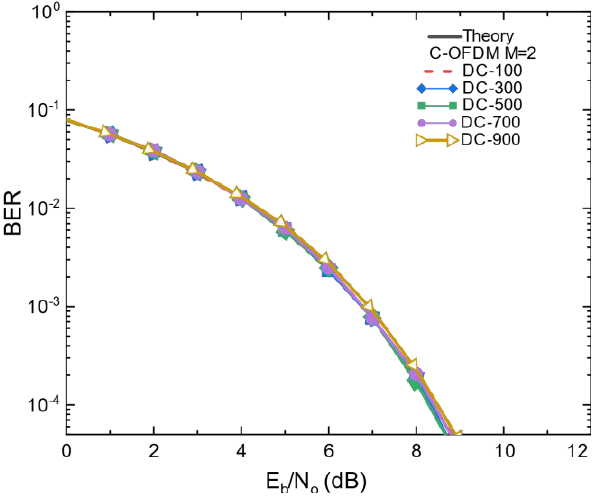
Figure 6. BER performance as a function of E b /N o for F-OFDM with 2-PAM and 200 AC.